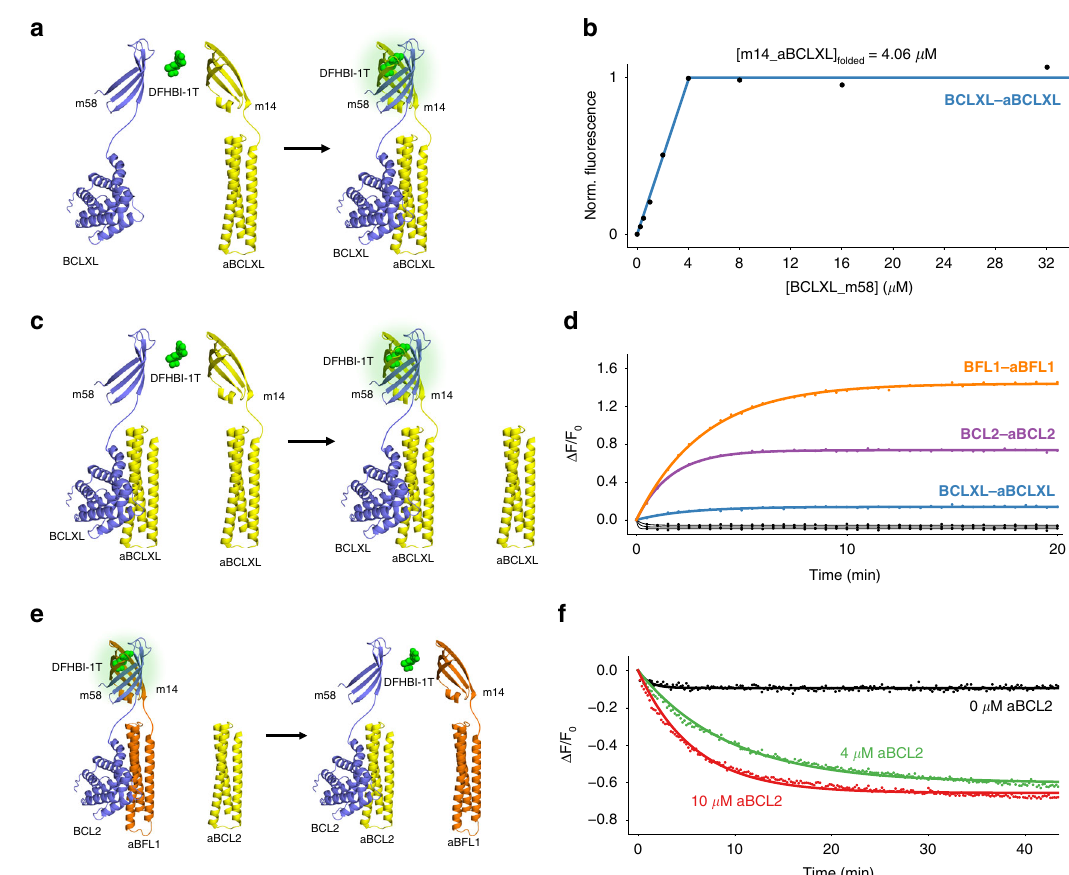
Fig. 6 Assembly and disassembly of bipartite split mFAP fragments m14 and m58. a – d Assembly of split mFAP fragments. a Association model in which BCLXL is fused to m58 (BCLXL_m58) (violet cartoon) , aBCLXL is fused to m14 (m14_aBCLXL) (yellow cartoon) , and fl uorescence of DFHBI-1T (green spheres) is activated upon association (arrow) of BCLXL_m58 and m14_aBCLXL. b Normalized fl uorescence intensity (points) of BCLXL_m58 titration into a constant m14_aBCLXL concentration in excess DFHBI-1T after reaching equilibrium, showing the fi t to a bimolecular association model (line) using non-linear least squares fi tting. c Split mFAP competitor pre-incubation model in which fl uorescence of DFHBI-1T (green spheres) is activated upon competition (arrow) of m14_aBCLXL with unfused aBCLXL (yellow cartoons) for the BCLXL-binding cleft of BCLXL_m58 (violet cartoon) (the reaction evolves analogously for BFL1 – aBFL1 and BCL2 – aBCL2 cognate-binding partners). d Temporal evolution of fl uorescence fold-change in excess DFHBI-1T upon ( n = 1) addition of equimolar m14_aBFL1 (orange points) or buffer (black points) to pre-incubated equimolar BFL1_m58 and aBFL1, addition of equimolar m14_aBCL2 (violet points) or buffer (black points) to pre-incubated equimolar BCL2_m58 and aBCL2, and addition of equimolar m14_aBCLXL (blue points) or buffer (black points) to pre-incubated equimolar BCLXL_m58 and aBCLXL, showing the fi ts to a monophasic exponential function (lines) using non-linear least squares fi tting. e , f Disassembly of split mFAP fragments. e Pre-assembled split mFAP competition model in which BCL2 is fused to m58 (BCL2_m58) (violet cartoon) , aBFL1 is fused to m14 (m14_aBFL1) (orange cartoon) , and fl uorescence of DFHBI-1T (green spheres) is activated before unfused aBCL2 (yellow cartoon) competes with m14_aBFL1 for the BCL2-binding cleft of BCL2_m58 (arrow) , resulting in fl uorescence deactivation. f Temporal evolution of fl uorescence fold-change in excess DFHBI-1T of pre-incubated equimolar BCL2_m58 and m14_aBFL1 at 2.00 µ M fi nal concentrations with unfused aBCL2 titrated in at ( n = 1) 0 µ M (black points) , 4.00 µ M (green points) , and 10.0 µ M (red points) fi nal concentrations, showing the fi ts to a monophasic exponential function (lines) using non-linear least squares fi tting. Source data is available for Fig. 6b, d,